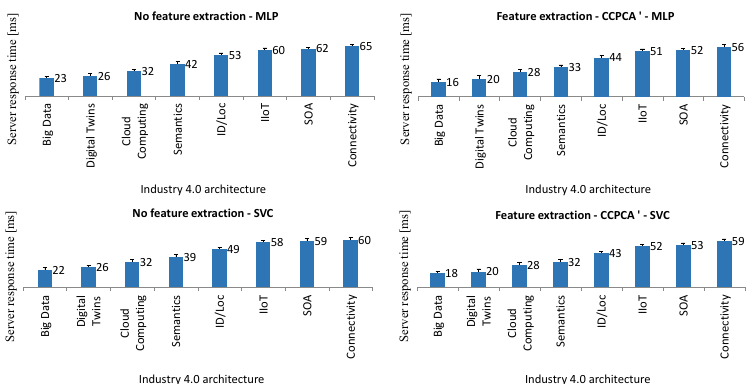
Figure 8. Graph of the dependence of times of obtained responses depending on the Industry 4.0